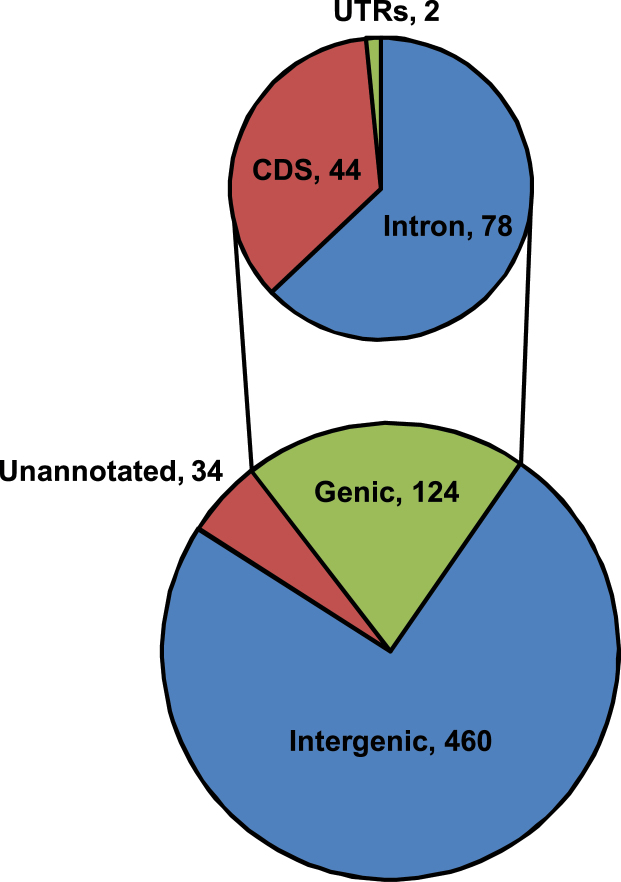
Annotation of 618 chickpea miRNAs. Distribution of miRNAs in different genomic features of the chickpea genome is shown in the Venn diagram. This figure is available in colour at JXB online.